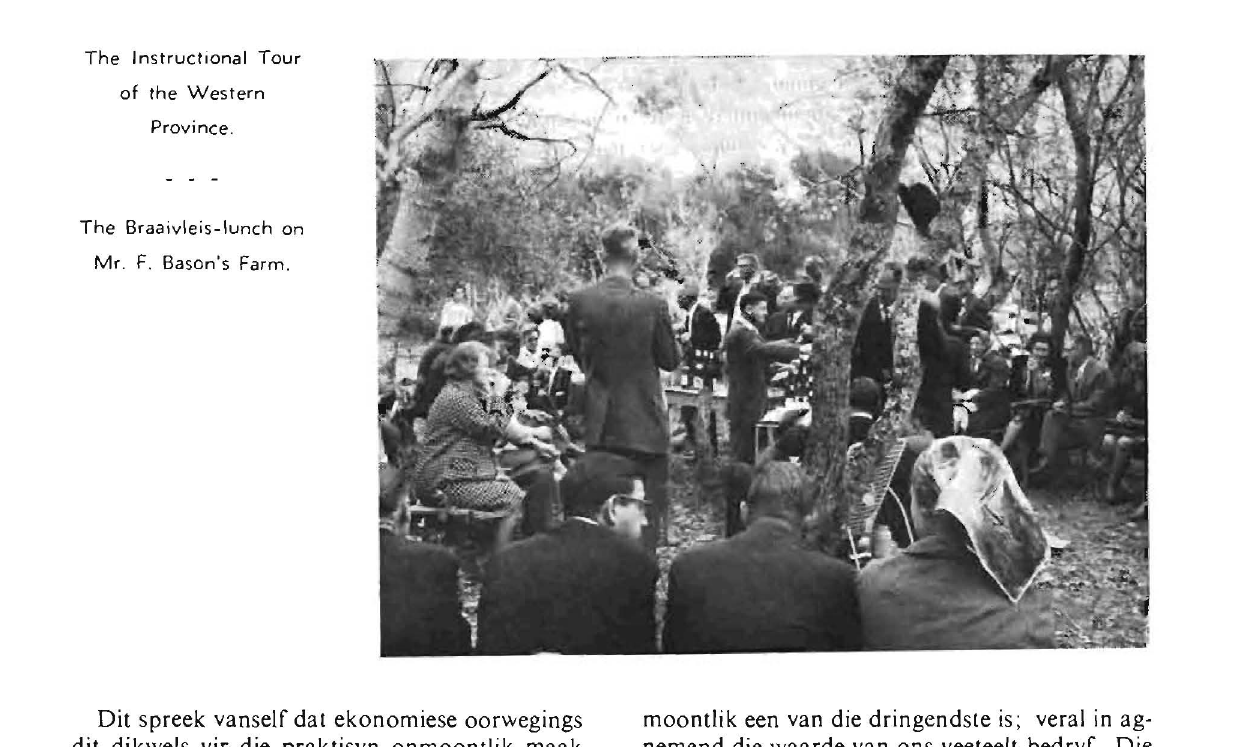
Dit spreek vanself dal ekonomiese oorwegings dit dikwels vir die praktisyn onmoonllik maak om op die platteland te bestaan, en op die oom blik daar 'n onoorbrugbare gaping lussen wal die boer kan bekostig om Ie betaal en wal die veearts moet verdien om sy belegging aan sy opvoeding en om 'n ordentlike lewensstandaard te regver dig. Tog voel ons dat deur die behoorlike ko ordinering van die baie bronne van diensver skaffing tot die beskikking van veeartse baie meer praktisyns op die platteland gevestig kan word. Die voorgestelde ondersoek sou onder andere die moontlikhede probeer nagaan en die nodige aanstelling verkry. Dit is vanselfsprekend dat verwikkelinge van die aard nie oornag kan gebeur nie maar alhoe wei hulle miskien met die verloop van tyd onwillekeurig tot stand mag kom is dit ons oortuiging dat daar doelbewus na geslreef moet word indien ons nie ons plig teenoor die vee boere wil versuim nie, soos wat ons oortuig is die geval in die verlede was. Die vooruitsig is dal ons vir baie jare nog aan daar 'n tekort aan allerlei opgeleides is maar dil is ons oortuiging dat die tekort aan